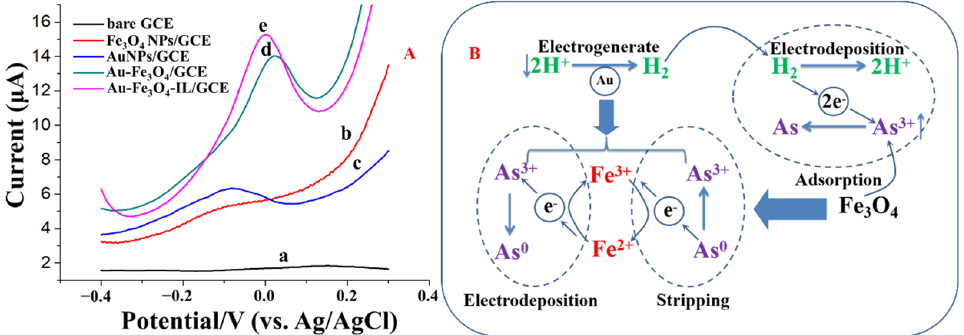
Figure 6. ( A ) The SWASV responses of 50 μg/L As(III) on different modified electrodes; (a) bare GCE, (b) Fe 3 O 4 NPs/GCE, (c) AuNPs/GCE, (d) Fe 3 O 4 -Au/GCE and (e) Fe 3 O 4 -Au-IL/GCE. ( B ) The catalytic mechanism of Fe 3 O 4- Au in the electroanalysis of As(III). Glassy carbon electrode (GCE); ionic liquid (IL).